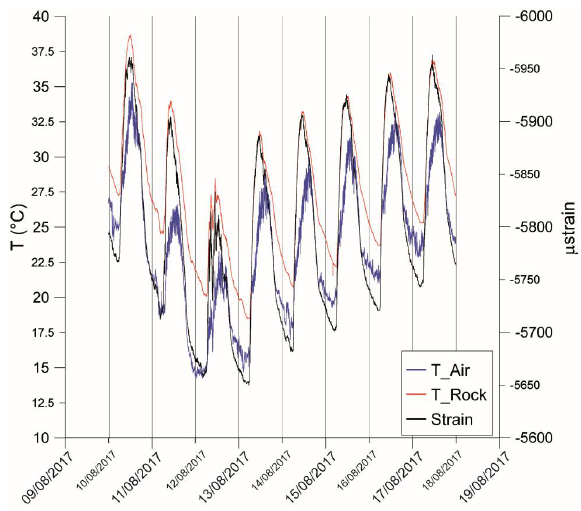
Figure 7. Example of the daily strain cycles over 10 days within the rock mass due to cyclic thermal input during the Summer season.